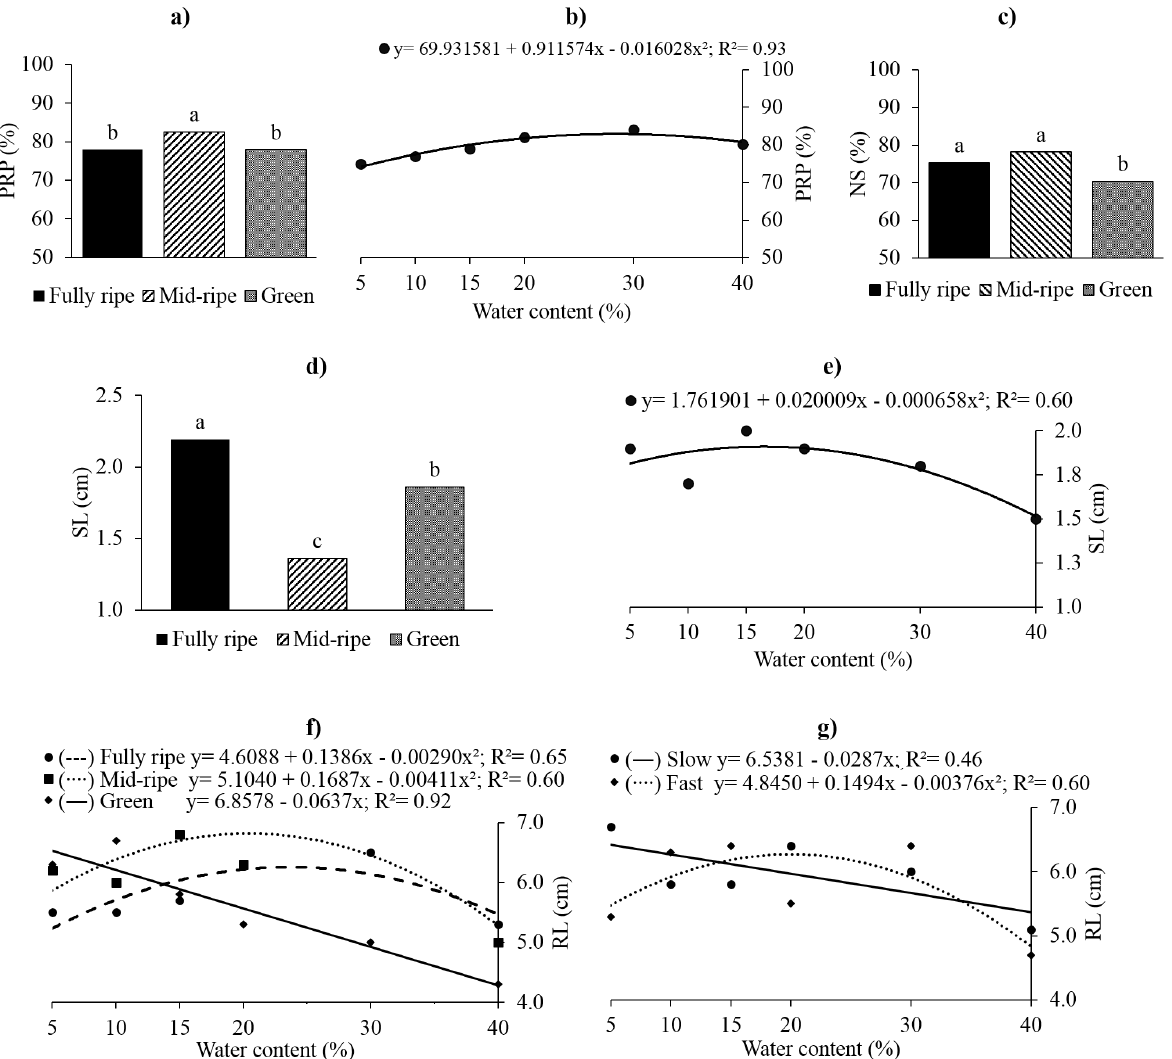
Figure 2 - Primary root protrusion - PRP % ( a , b ), normal seedlings NS % ( c ), shoot length (SL - cm) ( d , e ) and root length (RL - cm) ( f , g ) of A. edulis from fruit in various stages of ripening (fully ripe, mid-ripe and green) and drying of the seeds at different water